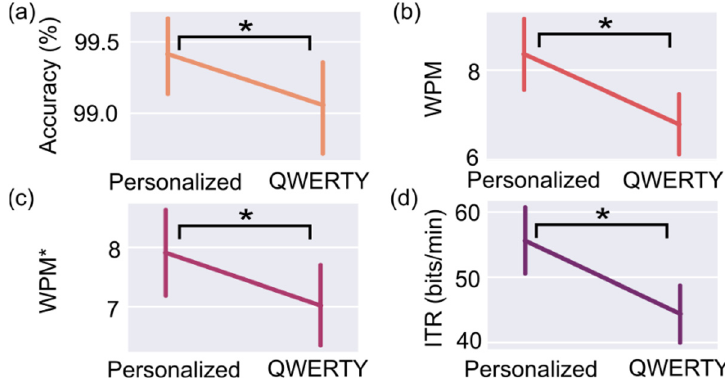
Figure 7. Marginal means for outcome measures of transcription tasks comparing personalized and QWERTY keyboards. ( a ) Target selection accuracy, ( b ) words per minute ( WPM ), ( c ) words per minute without space ( WPM* ), and ( d ) information transfer rate ( ITR ) shown across keyboards. Error bars represent 95% confidence intervals. * p < 0.05.